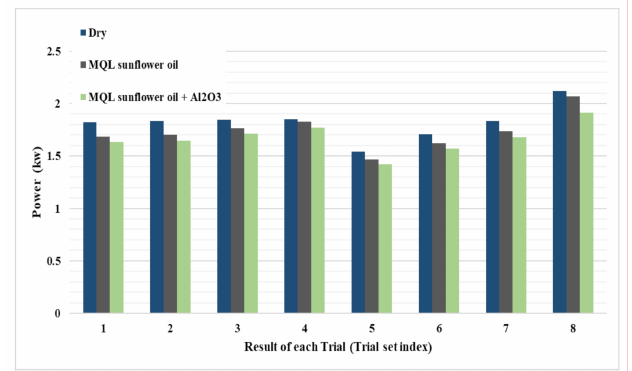
Figure 6. Comparison between the three cooling types (Dry, MQL and MQL + Al 2 O 3 ) on power consumption during finishing end milling of stainless steel